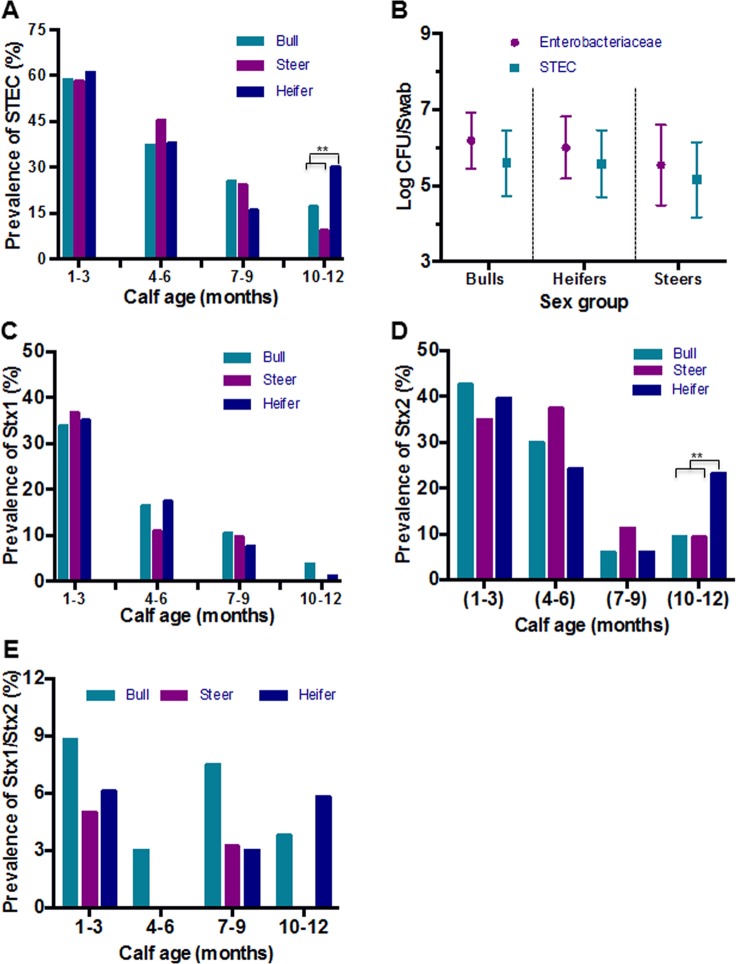
Prevalence of STEC among bulls, heifers and steers.(A) The prevalence of STEC in bull calves, steers and heifer calves during the first year of life is presented for any type of STEC and by individual genotype. Statistical comparisons between calves were examined using simple logistic regression to determine differences in prevalence. (B) Concentration of STEC and Enterobacteriaceae isolated from bull, steer, and heifer calves in four sampling points. (C) The prevalence of stx1 genotype in bull calves, steers and heifer calves. (D) The prevalence of stx2 genotype in bull calves, steers and heifer calves. (E) The prevalence of stx1/stx2 genotype in bull calves, steers and heifer calves.